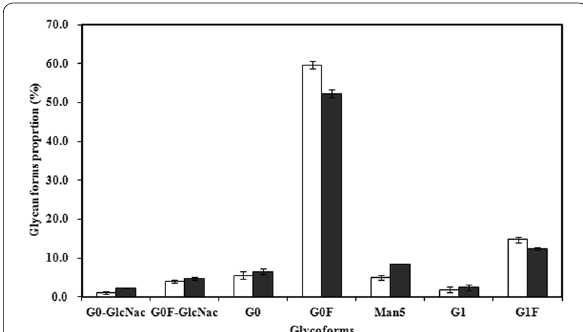
Fig. 3 Glycoform proportion of mAb in two fed‑batch cultures. (White bar) control condition; (shaded bar) uridine added condition. The error bars indicate the standard deviations from three independent experiments and p ‑values were estimated by two‑tailed Student’s t